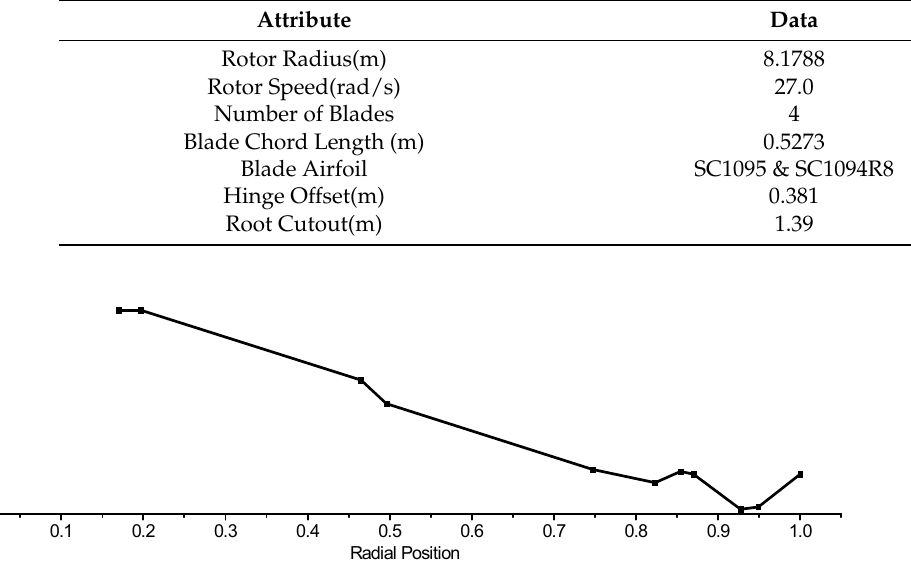
Figure 4. Pre-twist distribution of the UH-60A blade.